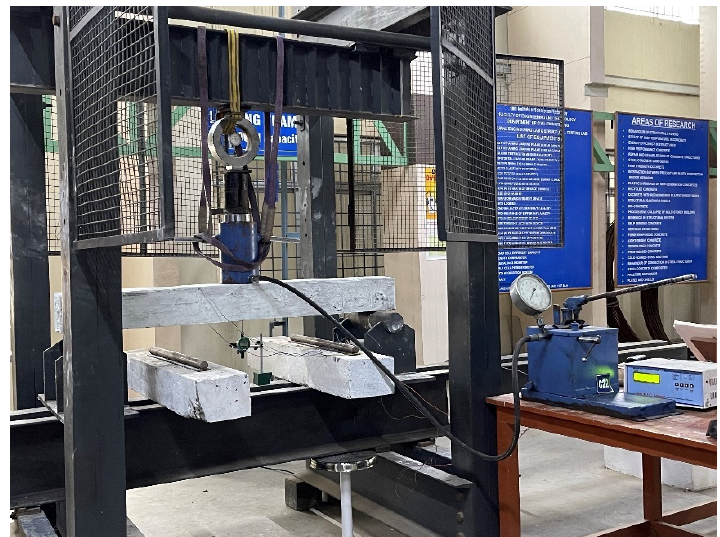
Figure 9. Experimental setup for testing of beam.